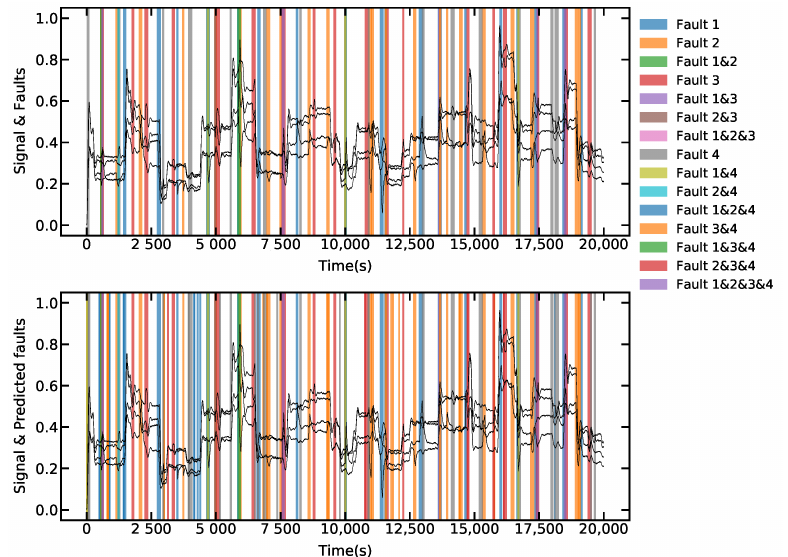
Figure 10. Process faults detection, the faults are represented in the shaded areas, states are given in black for reference. Above: faults labeled in the data-set. Below: faults detected by the